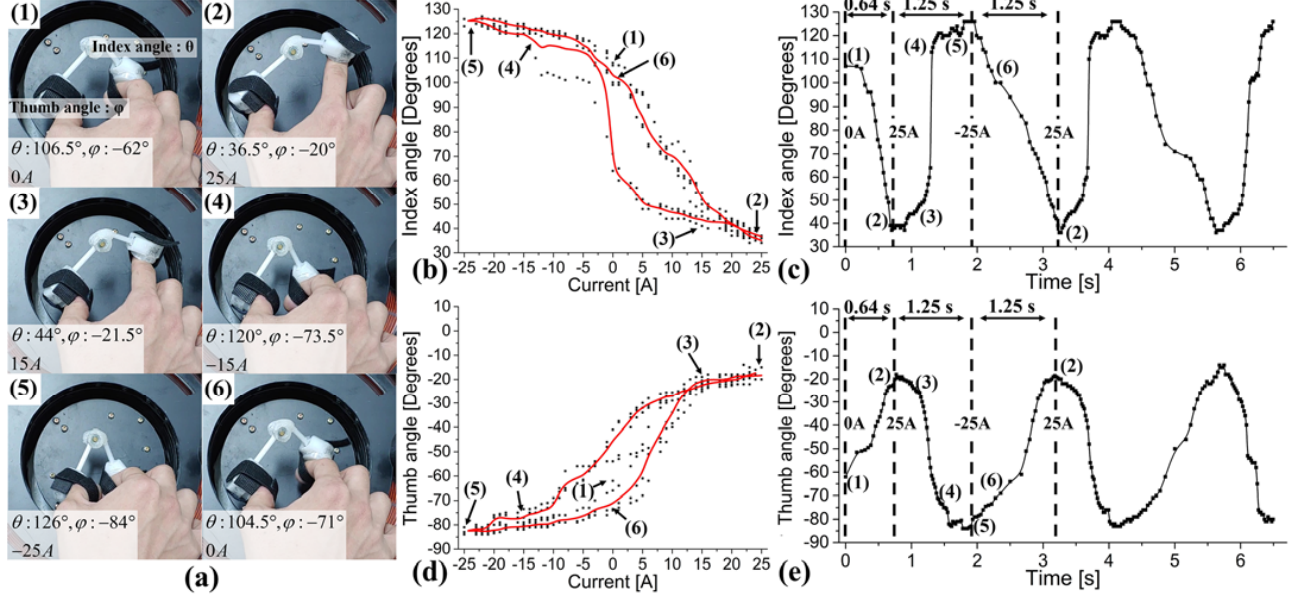
Figure 6. ( a ) Thumb and index finger postures during pinch motions using the proposed mechanism. ( b ) Index finger angle variations according to changes in time. ( c ) Hysteresis property of the index finger: index finger angle variations according to changes in the driving current. ( d ) Thumb angle variations according to changes in time. ( e ) Hysteresis property of the thumb: thumb angle variations according to changes in the driving current.